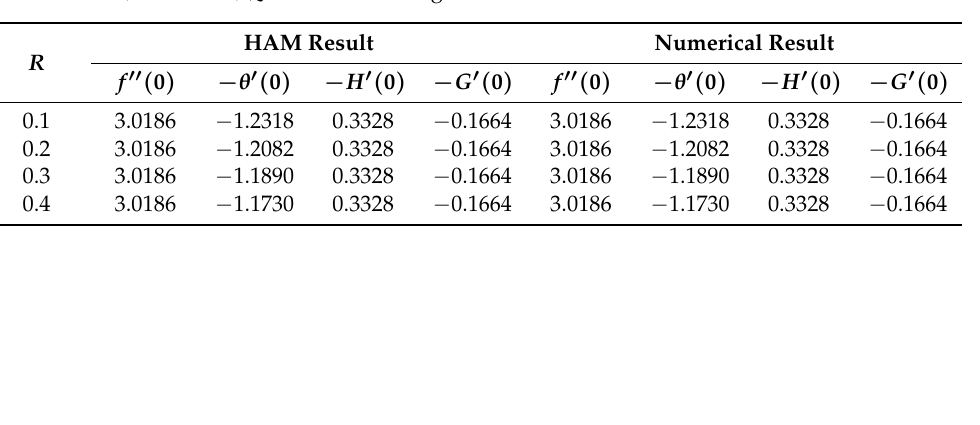
Table 9. Computational for f (cid:48)(cid:48) ( 0 ) , − θ (cid:48) ( 0 ) , − H (cid:48) ( 0 ) and − G (cid:48) ( 0 ) with S = − 0.5, P r = Ha = Sc = K 1 = K 2 = 0.5, L = δ = 2, Q = 4 and differing values of R